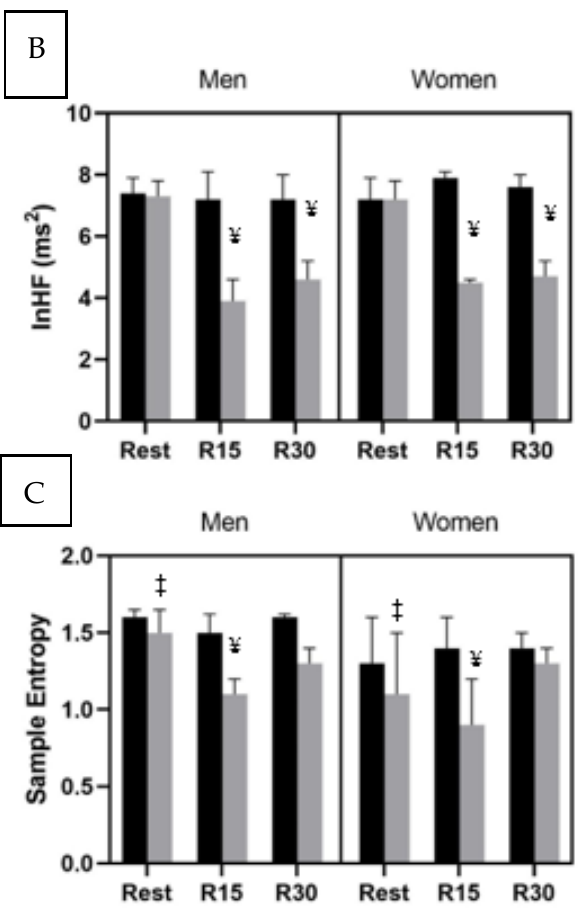
Figure 2. Alterations in vagal modulation (mean ± 95% confidence intervals) measured via ( A ) ln root means square of successive differences (lnRMSSD), ( B ), ln high-frequency power (lnHF), and ( C ) sample entropy at rest, as well as 15 (R15), and 30 min following a control and an acute bout of resistance exercise in resistance-trained men (n = 11) and women (n = 10). Values are mean ± SD. ¥ significantly different from rest ( p = 0.0001), ‡ significantly different from men ( p = 0.03).